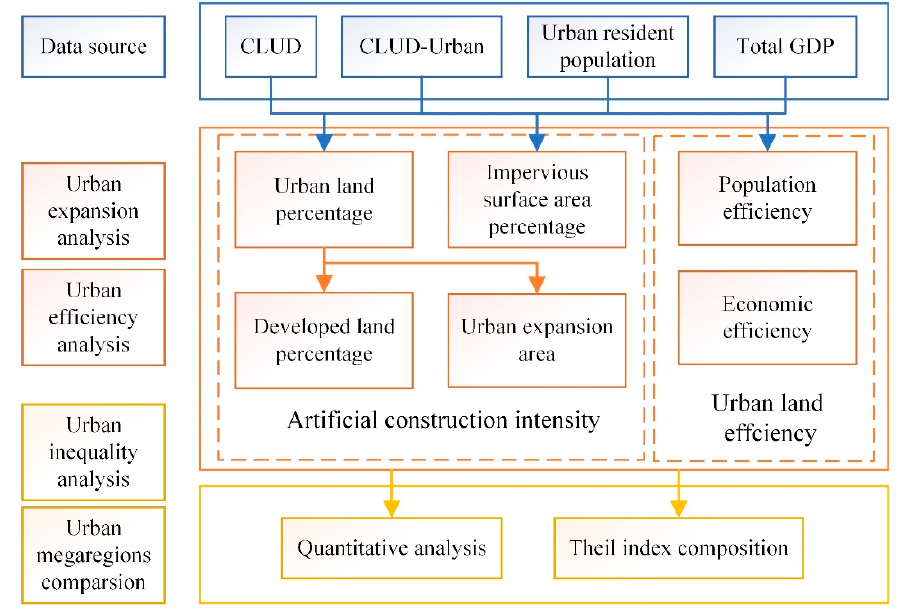
Figure 2. Flow chart on analysis of artificial construction intensity and urban land efficiency.